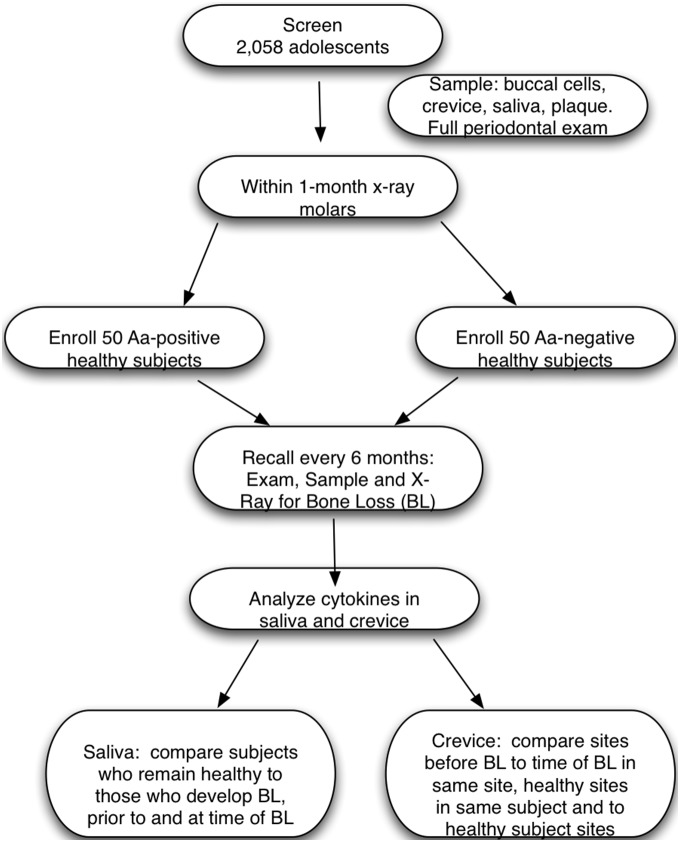
Flow Diagram of subjects participation in study.Fifty Aa-positive and 50 Aa-negative subjects were enrolled and followed every 6 months for up to 3 years. Cytokines from saliva and crevice fluid were collected every 6 months, stored, and then after bone loss was detected, salivary samples from 10 of those subjects (from a total of 16) and saliva from another 60 subjects who remained healthy was analyzed. In the case of crevice fluid, samples from 16 subjects who developed bone loss and another 38 who remained healthy was available for analysis.